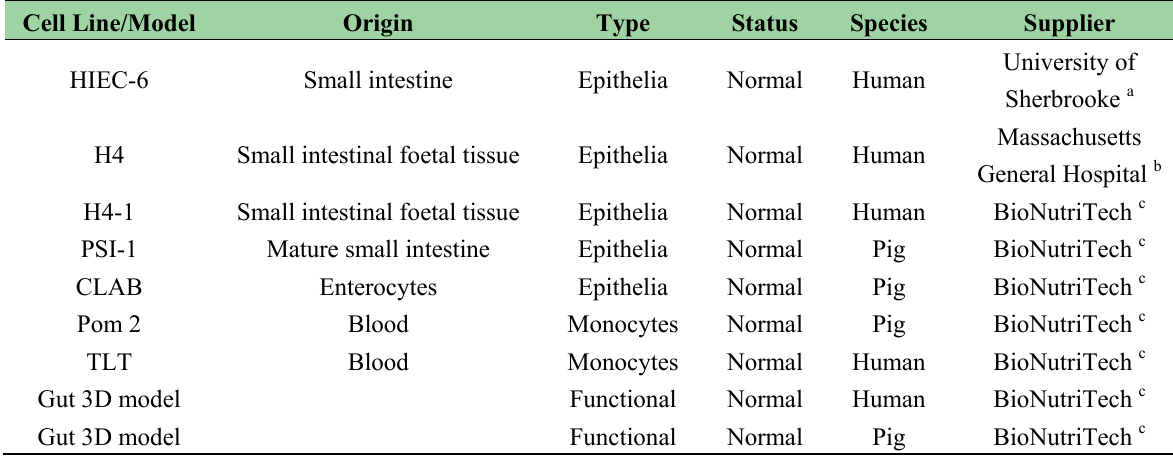
Table 1. Available cell lines and cell models of the pig and human gut